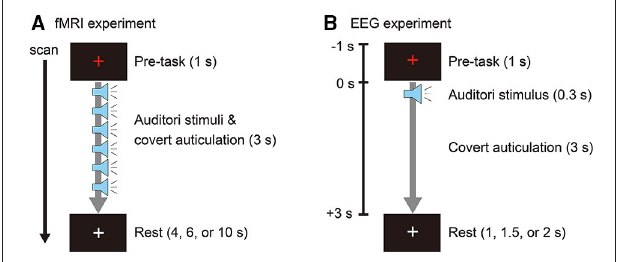
FIGURE 1 | (A) Event-related design for the fMRI experiment. One trial consisted of a pre-task (1s), task (3s) with six auditory stimuli (0.3s each), and rest (4, 6, or 10s). The rest duration was randomly assigned for each trial. The color of the fixation cross was red during the pre-task and task intervals. (B) Experimental design for the EEG experiment. One epoch consisted of a pre-task (1s), task (3s) with auditory stimulus (0.3s), and rest (1, 1.5, or 2s). The rest duration was randomly assigned for each epoch. The color of the fixation cross was red during the pre-task and task intervals. estimating cortical currents from EEG (Sato et al., 2004).